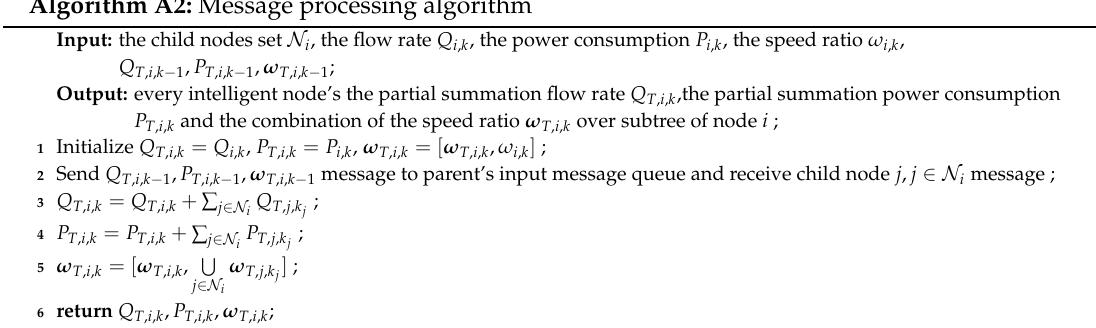
Algorithm A2: Message processing